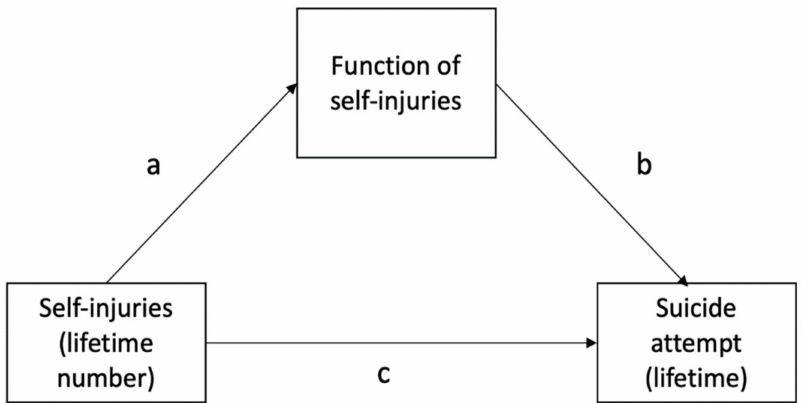
Figure 1. The mediation model tested in the present study. Direct effects are shown: a – direct effect of self-injuries (lifetime number) on function of self-injuries; b – direct effect of function of self-injuries on suicide attempt risk (lifetime) and c – direct effect of self-injuries (lifetime number) on suicide attempt risk (lifetime).